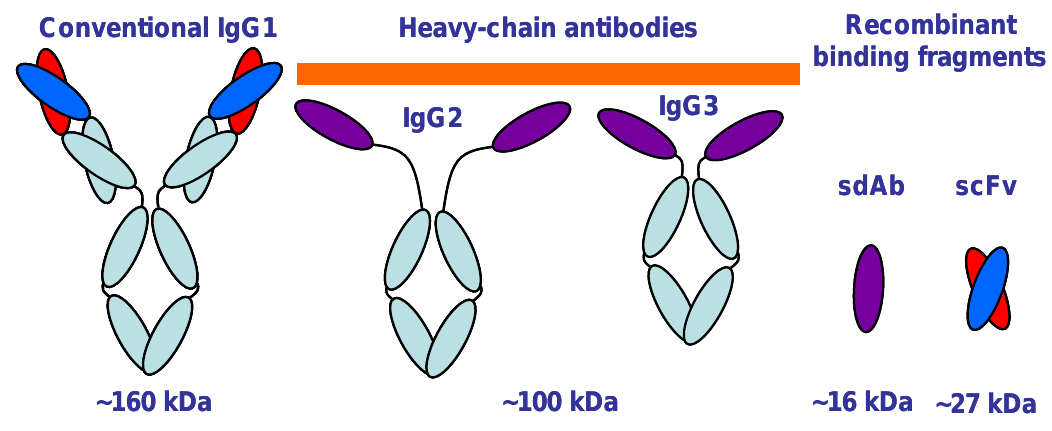
Figure 1 . Cartoon showing conventional antibodies, heavy chain antibodies, and their cloned binding elements. Variable domains have been colored red and blue for the conventional VH and VL respectively, and purple for the